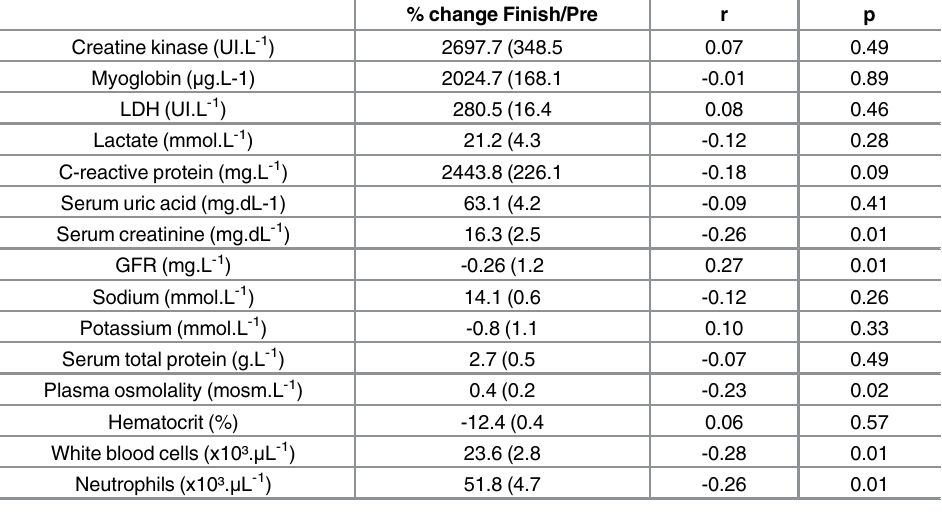
Table 5. Percent changes in biomarker levels and shear modulus values between the Finish and Pre sessions (% change